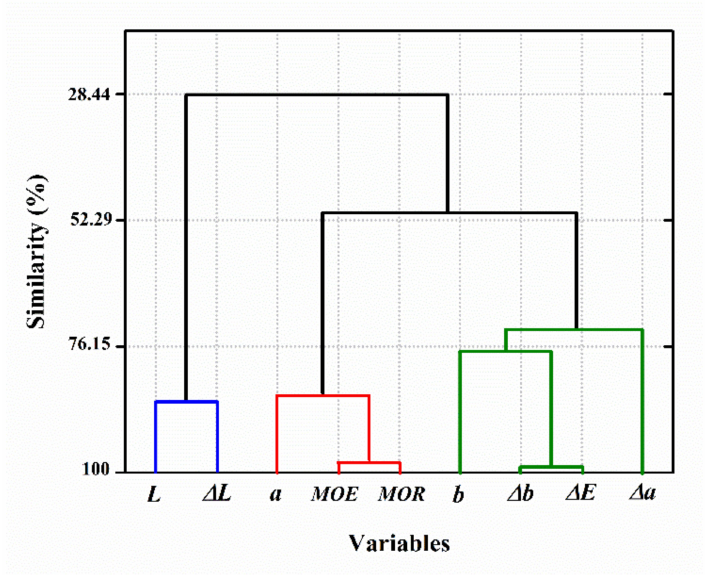
Figure 12. Variable clustering analysis on the color parameters, MOE and MOR (the blue, red and green lines represent the components of the CIELAB three-dimensional color